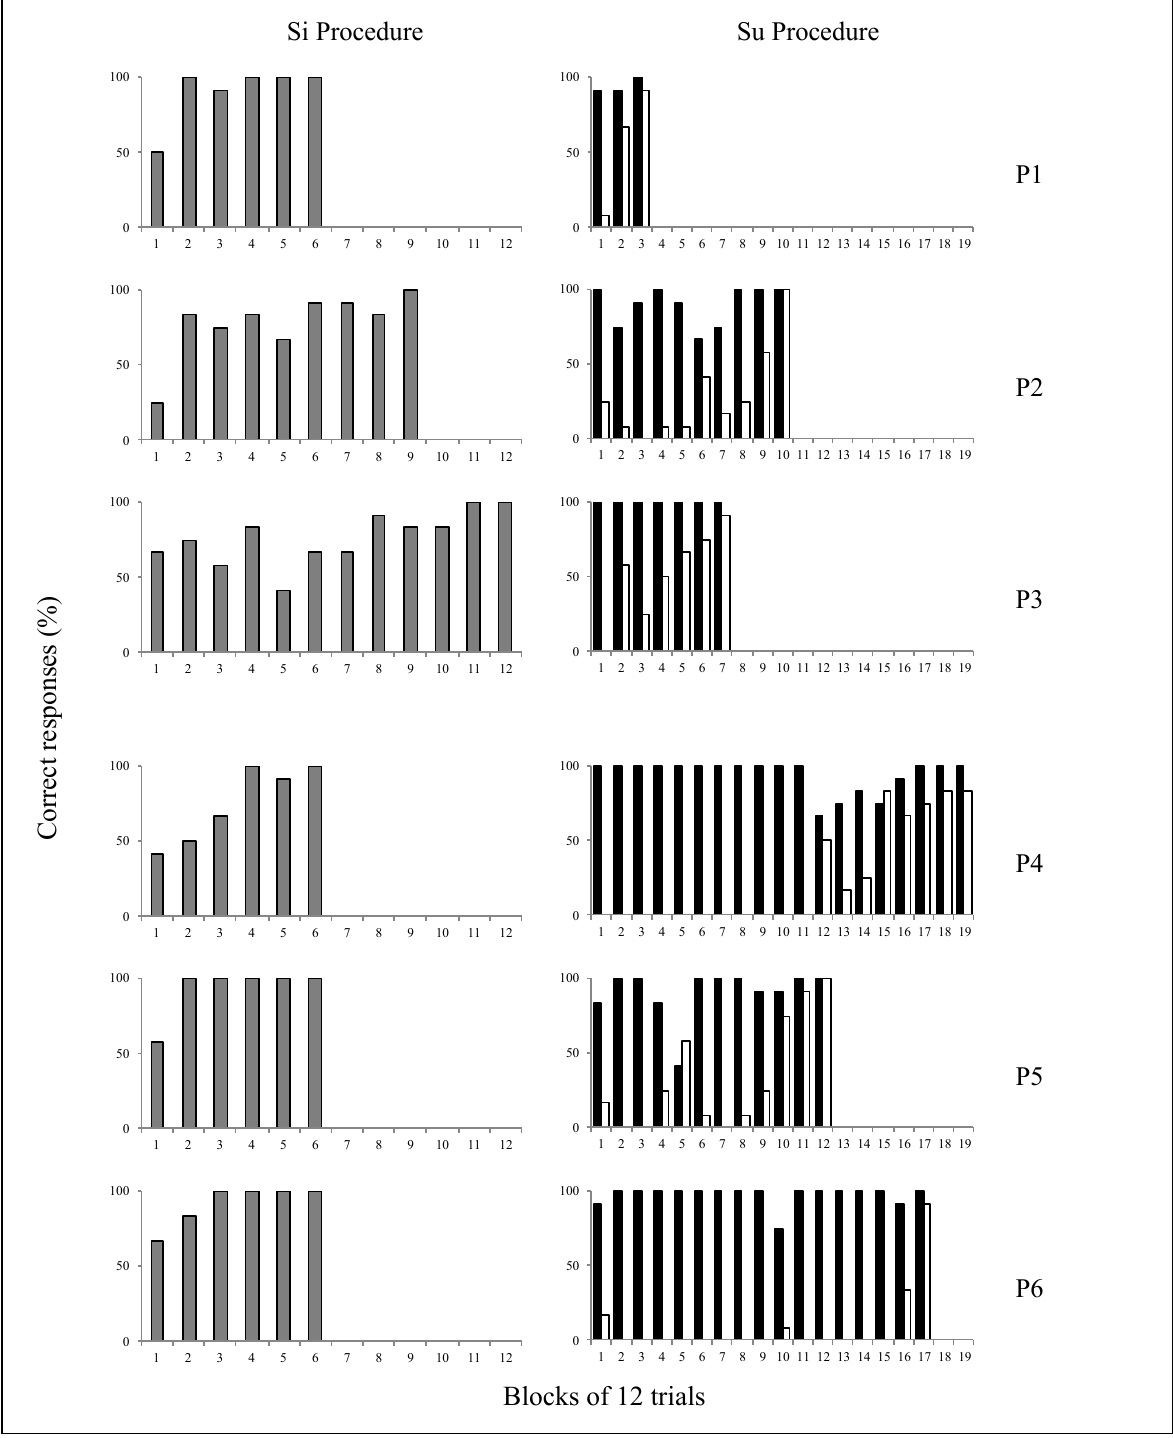
Figure 3 . Percentage of correct responses in blocks of 12 trials in the Si and Su Procedures. In the left portion, gray bars represent the percentage of correct responses obtained by the participants during the Si Procedure. The right portion presents the results of the participants during the Su Procedure; the black bars represent the percentage of correct responses in trials that presented the Set 3 stimuli and the white bars represent the percentage of correct responses in trials with the Set 4